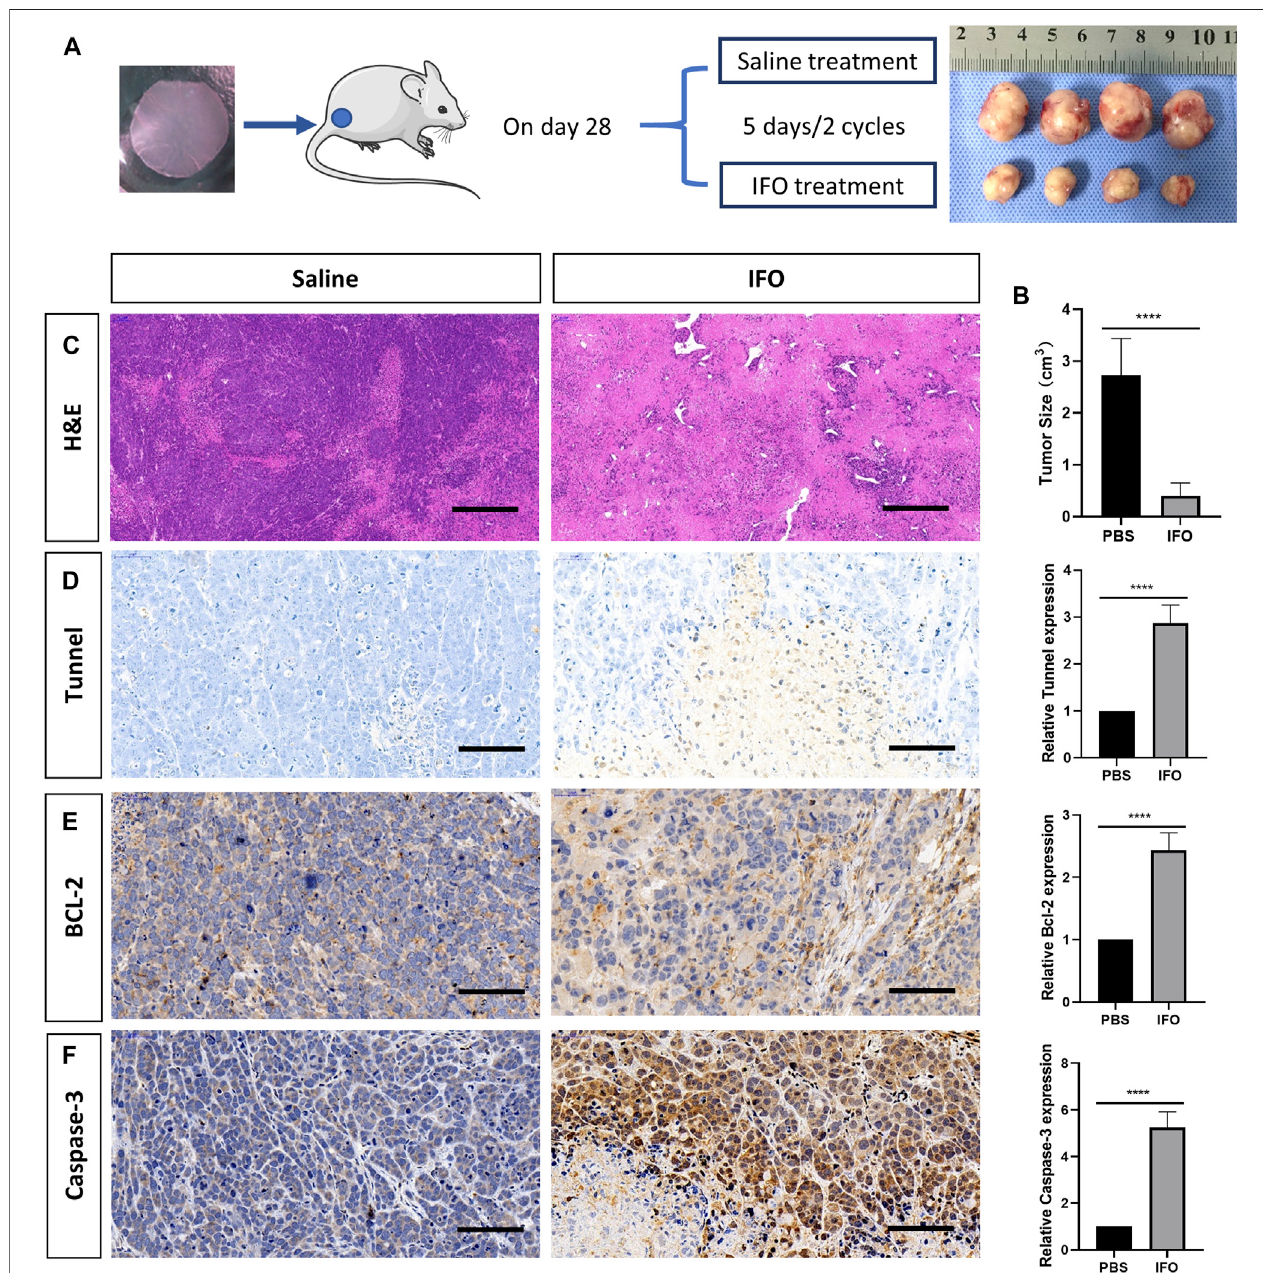
FIGURE5 | Apoptosis analysis oftumor after treatment ofifosfamide (IFO). (A) Schematic graphof the treatment plan and theresult tumor sampleafter treatment. (B) Hematoxylin and eosin staining of the representative bone lesion from saline and IFO treatment group, respectively. (C) Tumor size after the treatment in each group (D) TUNEL staining of the representative bone lesion from saline and IFO treatment group, respectively. (E) BCL-2 staining of the representative bone lesion from saline and IFO treatment group, respectively. (F) Caspase-3 staining of the representative bone lesion from PBS and IFO treatment group, respectively. Statistical signi fi cance was calculated by Student ’ s t test. **** p < 0.0001. Scale bar (cid:2) 200 μ